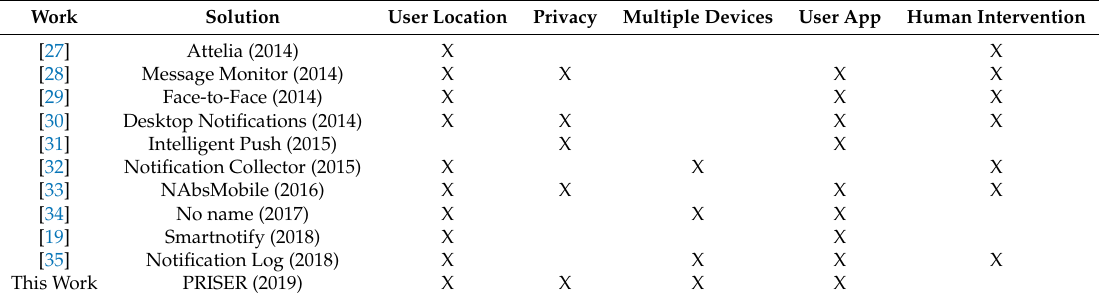
Table 1. Related Work.